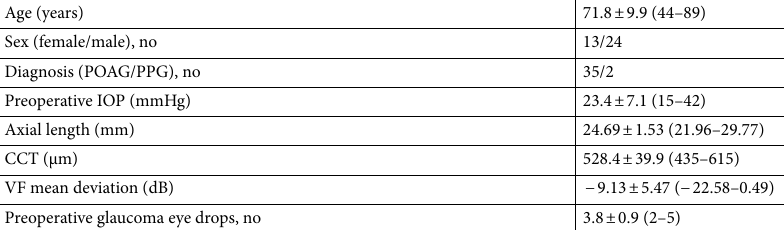
Table 1. Demographic and clinical characteristics of the patients (N = 37). Data (except sex and diagnosis) are presented as the mean ± standard deviation with the minimum and maximum values in parentheses. CCT = central corneal thickness; IOP = intraocular pressure; POAG = primary open-angle glaucoma; PPG = preperimetric glaucoma; VF = visual field.